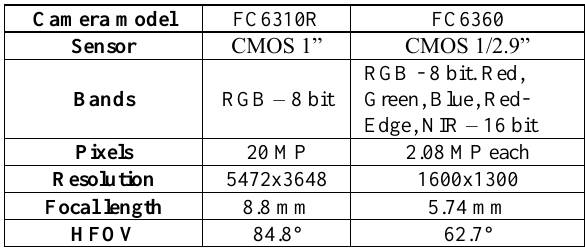
Table 1. Technical specification of optic image systems.